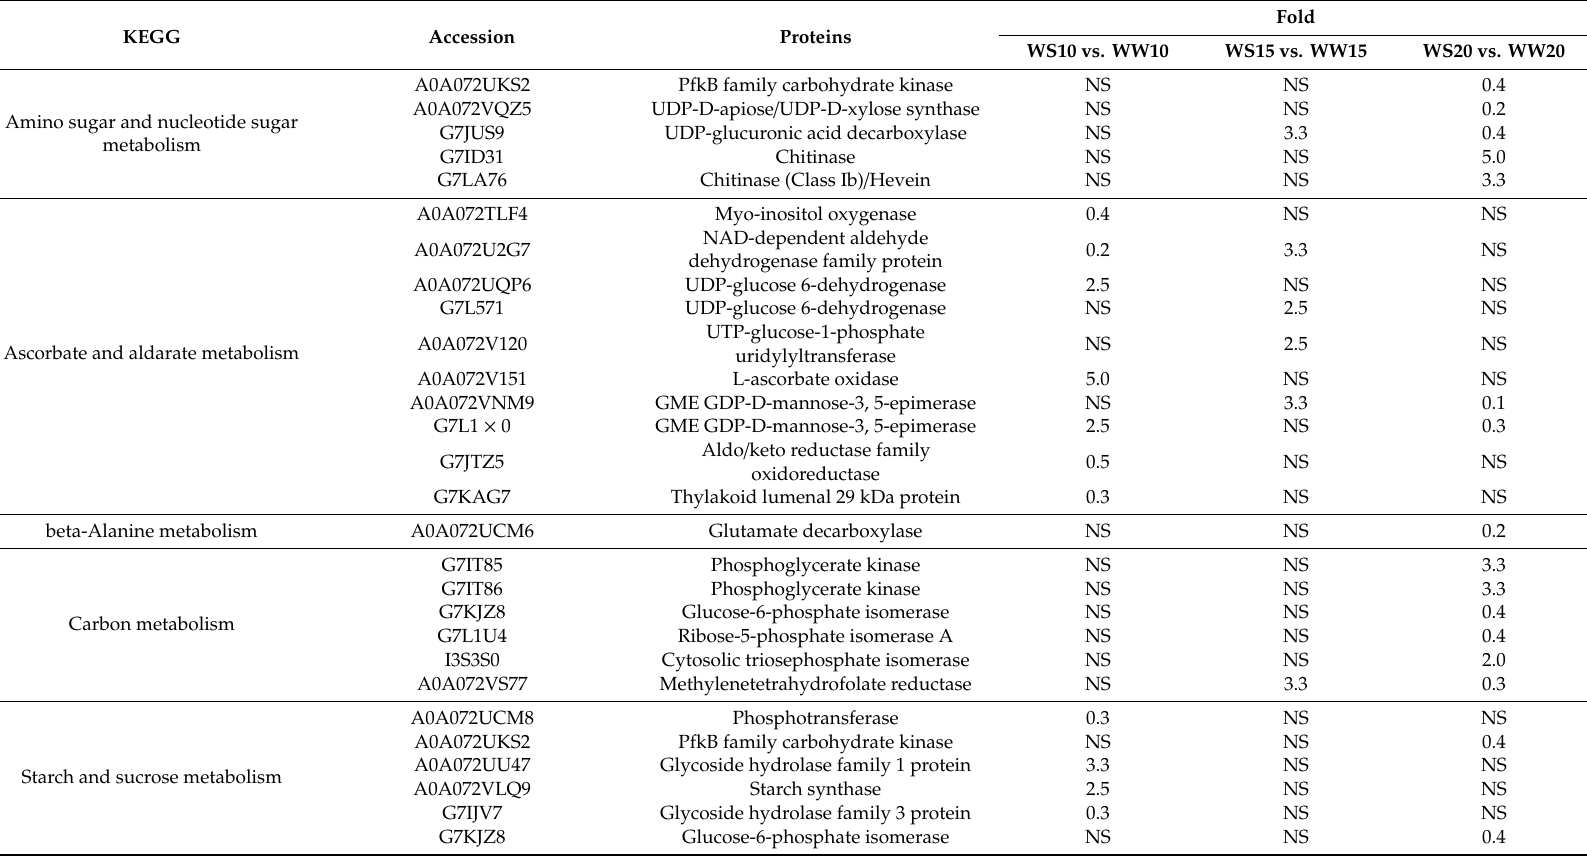
Table 2. Di ff erent expression of proteins involved in some pathways in the pod wall under drought